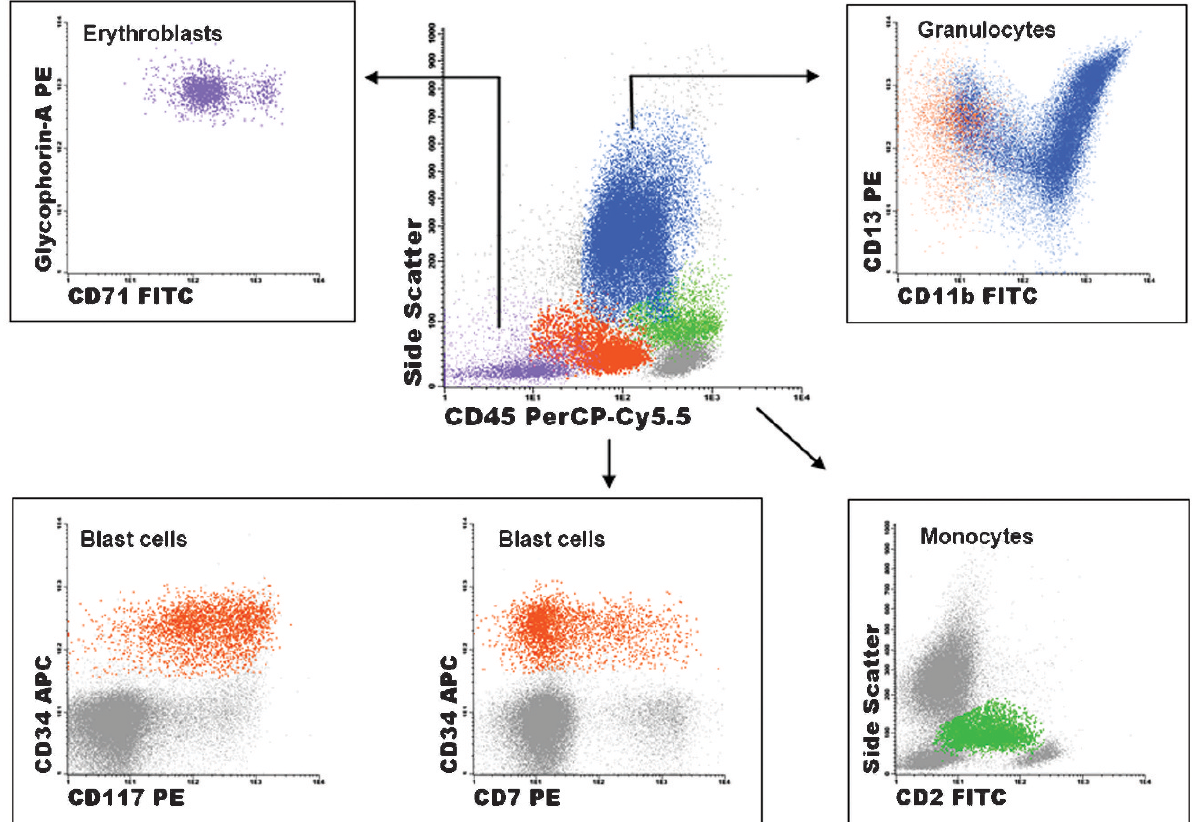
Figure 1 - Immunophenotypic analysis of bone marrow cell compartments: the blast cells (orange) are CD34 + and CD117 + with partial expression of CD7; the erythroblasts (purple) present glycophorin-A and low expression of CD71; the maturing granulocytes (blue) demonstrate an anomalous maturation pattern of CD13/CD11b expression, with increased levels of CD13 and CD11b during intermediate maturation stages; the monocytes (green) express aberrant